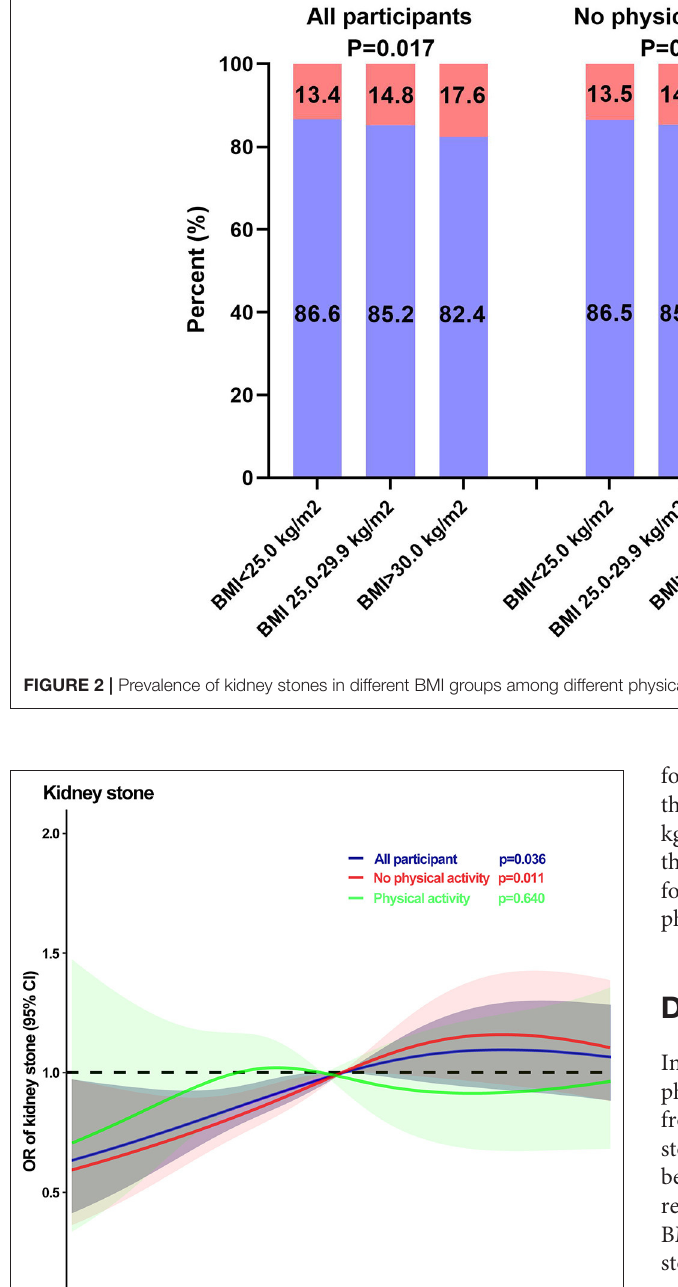
FIGURE 3 | The dose–response analysis of kidney stones with BMI by physical activity type. OR, Odds ratio; CI, Confidence interval.